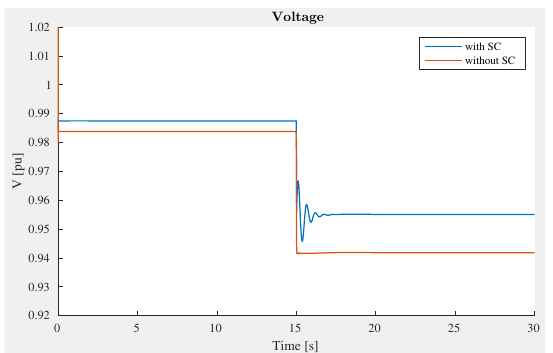
Figure 5. Comparison of the voltage at bus 6.